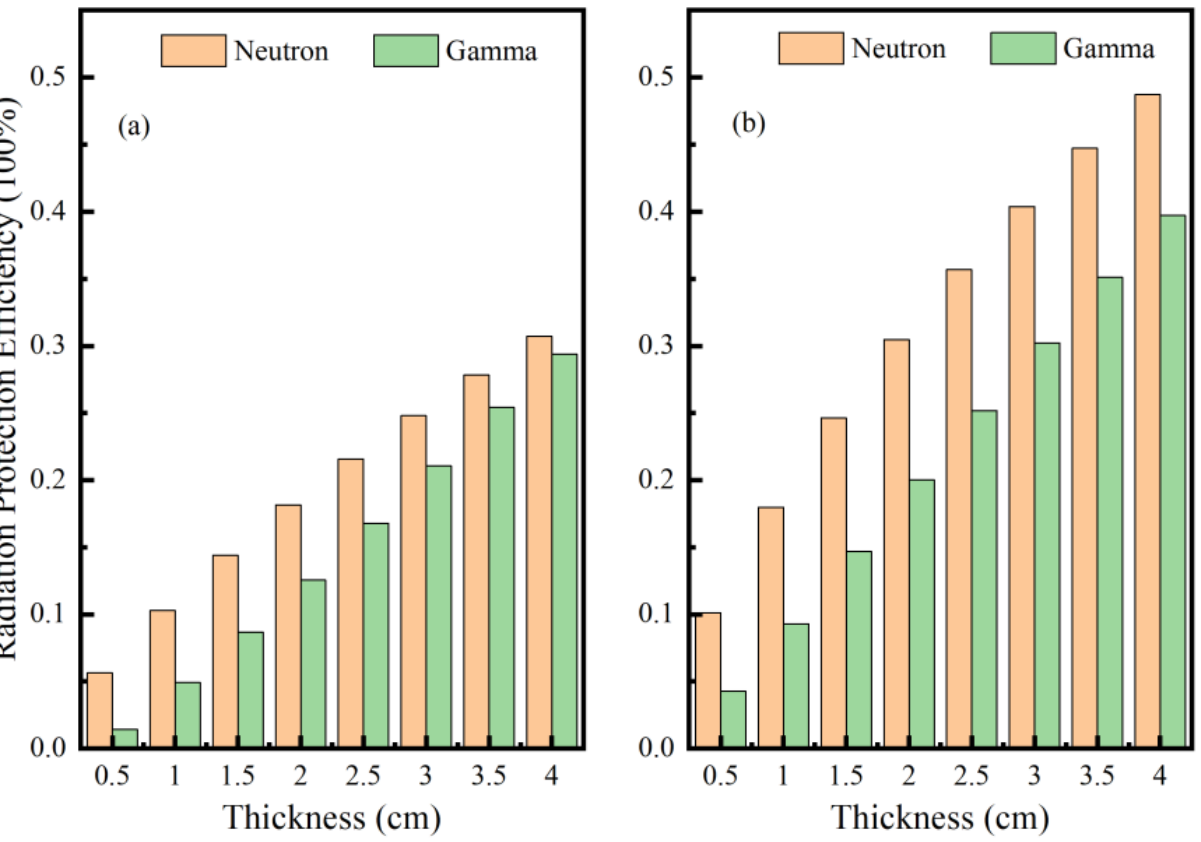
Figure 4. Radiation protection efficiency ( RPE ) of lead and tungsten to neutron and gamma rays at different thicknesses ( a ) Shielding rate of lead with increasing thickness; ( b ) Shielding rate of tungsten with increasing thickness.